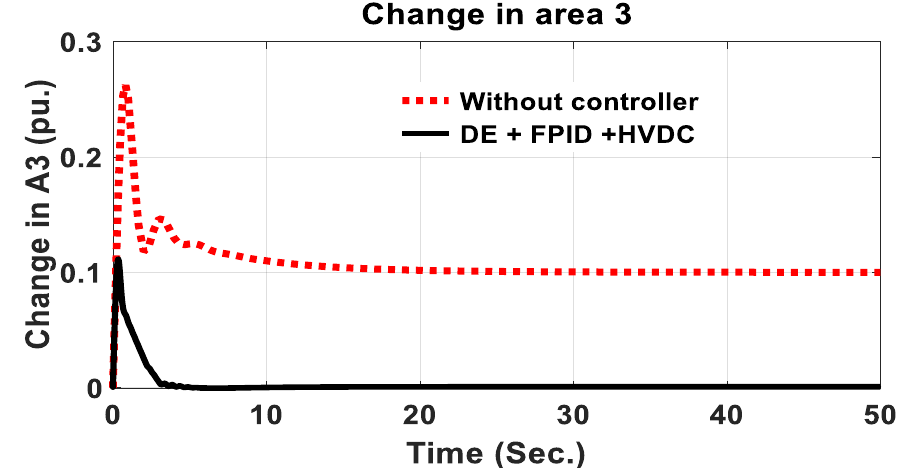
Figure 10. Comparison of controller and without controller for change in ACE 3.